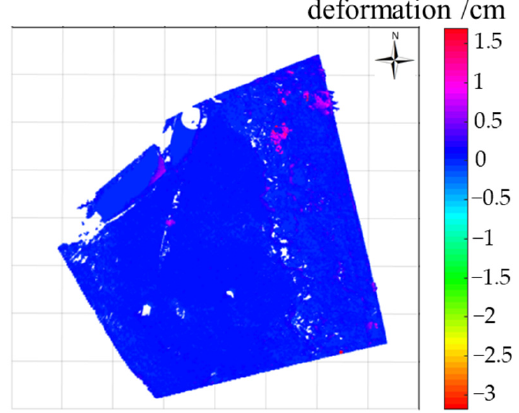
Figure 25. Deformation of Lashagou NO.3 landslide.